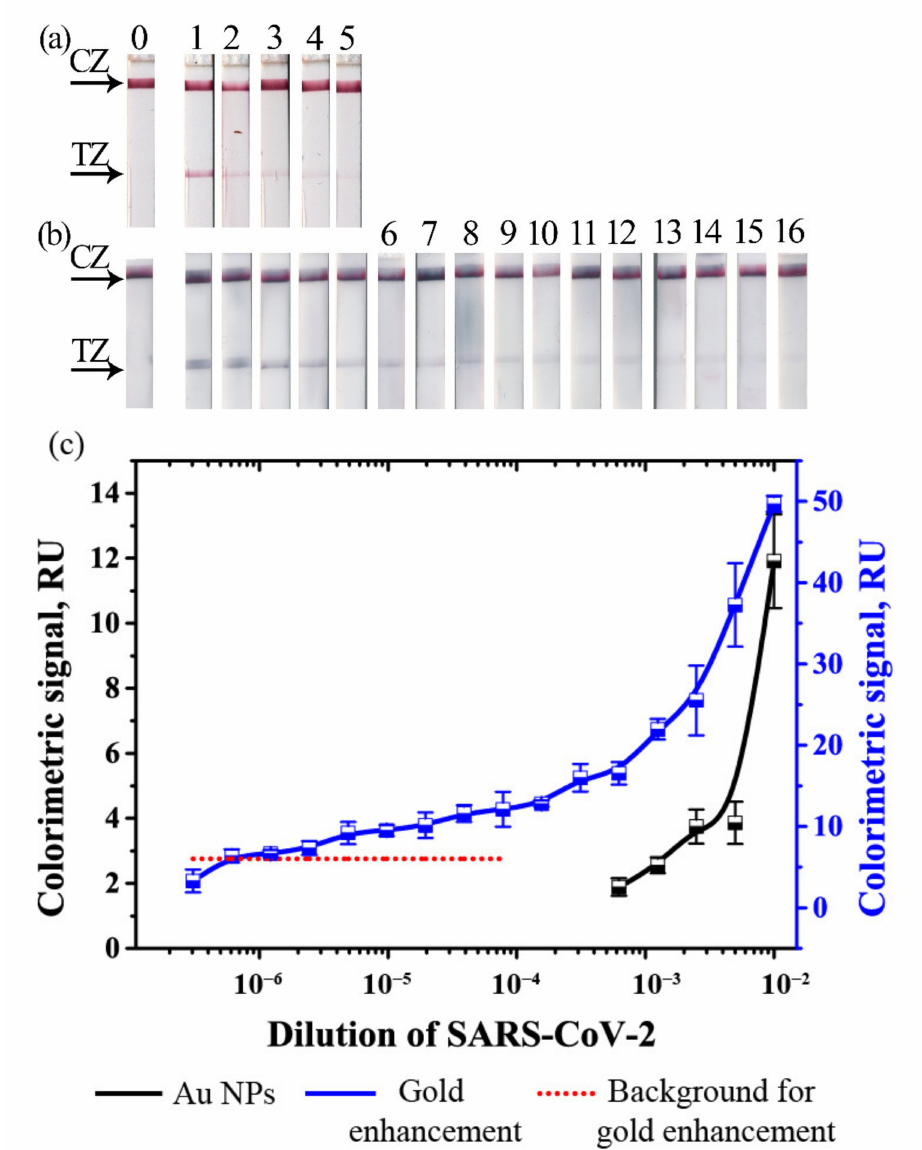
Figure 4. LFIA of SARS-CoV-2 virions in saliva. ( a ) Test strips with Au NPs; ( b ) Test strips after gold enhancement; ( c ) Calibration plots for LFIA with Au NPs and after gold